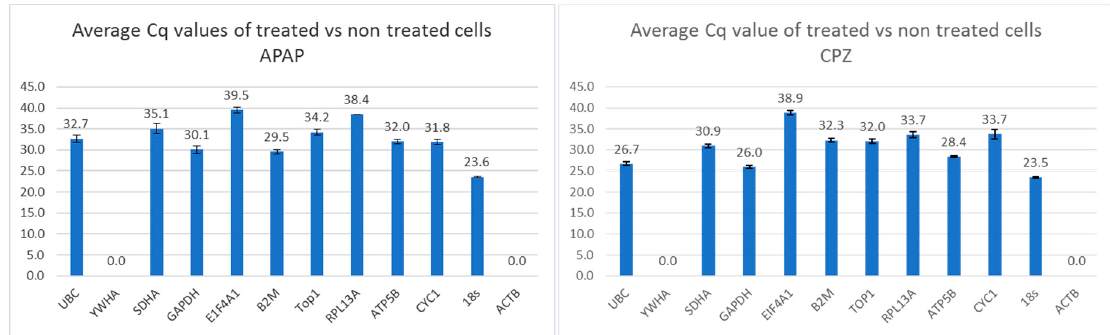
Figure 1. The RNA transcription of the tested reference genes in absolute Cq values over all investigated samples (cells stimulated with different doses of chlorpromazine (CPZ) or acetyl-para-aminophenol (APAP) and untreated cells). Values of Cq>40 are excluded.